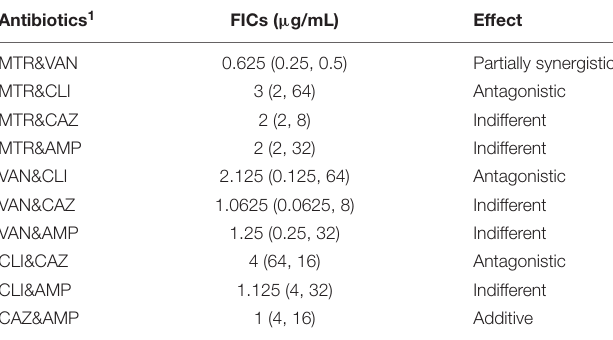
TABLE 2 | Fractional inhibitory concentrations (FICs) of the five